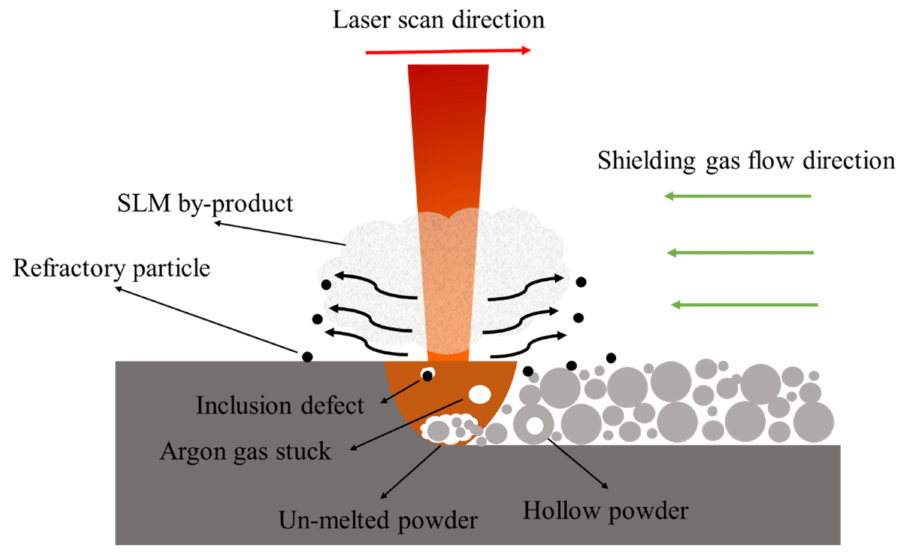
Figure 12. The defects forming the mechanism in the SLM